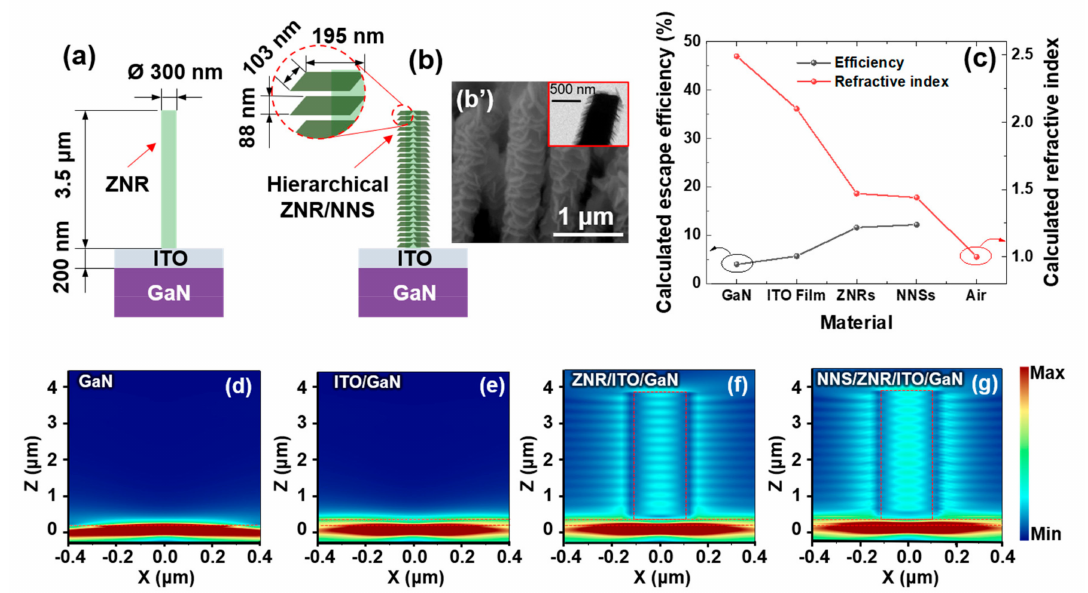
Figure 4. Layouts of the C-emitters with ( a ) ZNR and ( b ) hierarchical ZNR / NNS. ( b’ ) FESEM and transmission electron microscope (inset) images of the hierarchical ZNR / NNS arrays. ( c ) Calculated refractive indices and escape e ffi ciencies. ( d – g ) Electric field propagation for various